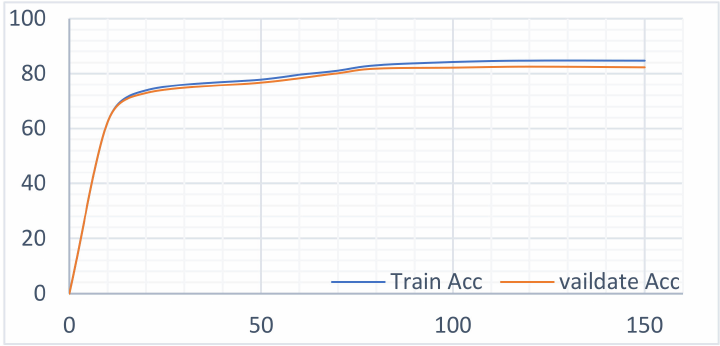
Figure 12. Training accuracy of different epochs.